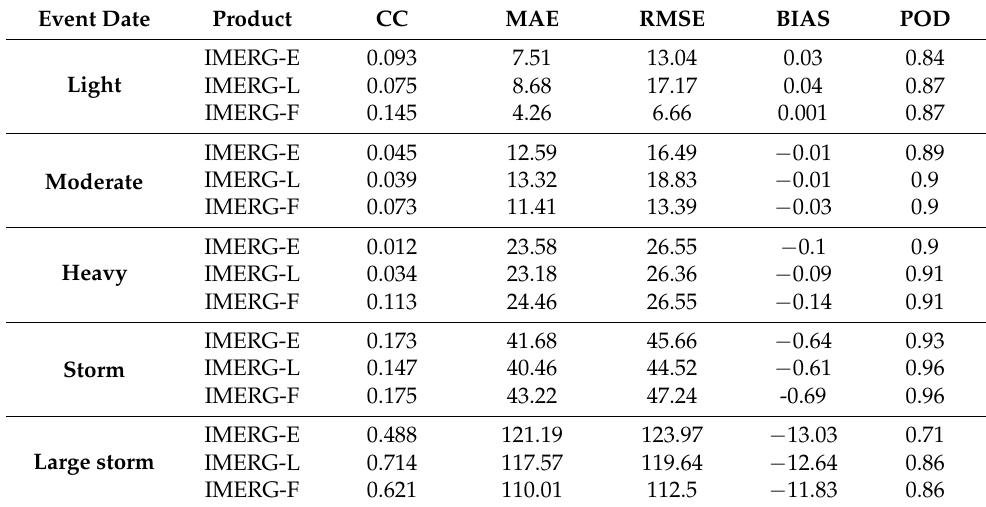
Table 6. Rainfall intensity-based evaluation